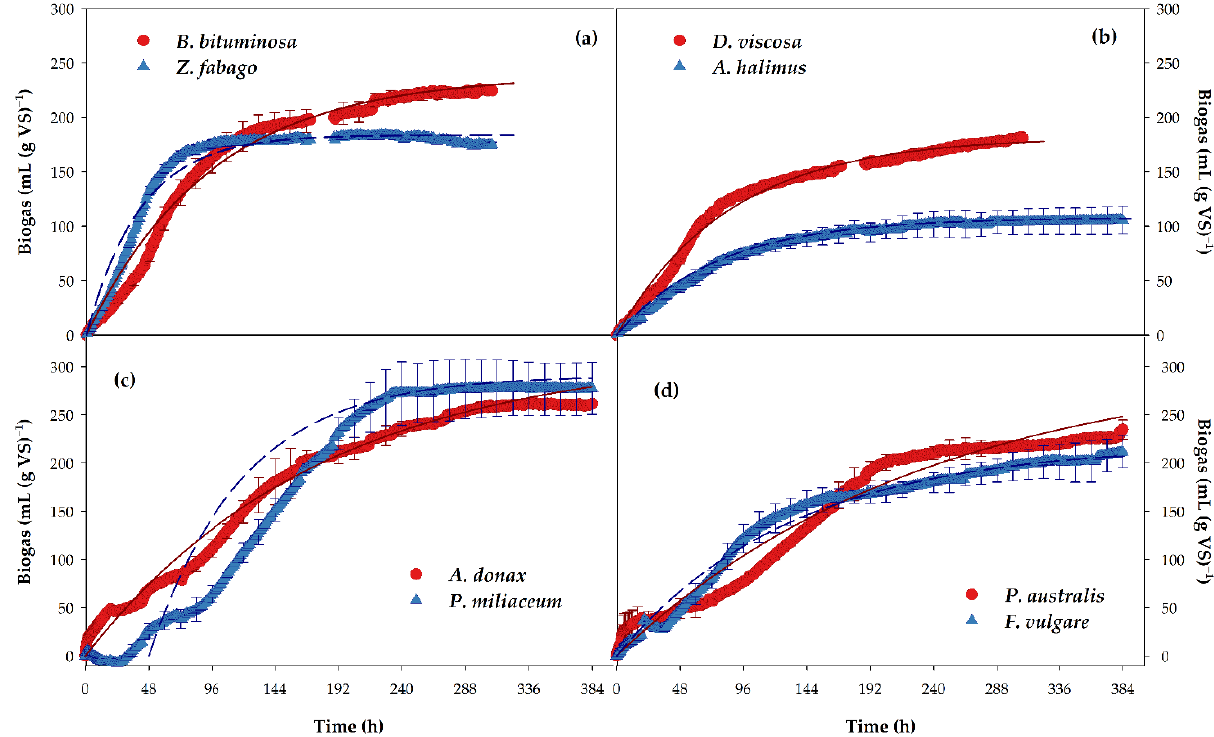
Figure 1. Biogas production from the plants ( Bituminaria bituminosa and Zygophyllum fabago ( a ), Dittrichia viscosa and Atriplex halimus ( b ), Arundo donax and Piptatherum miliaceum ( c ) and Phragmites australis and Foeniculum vulgare ( d )) under anaerobic conditions. The symbols represent the experimental data and the lines signify the degradation predicted by a first-order kinetic model for each sample (n = 2).